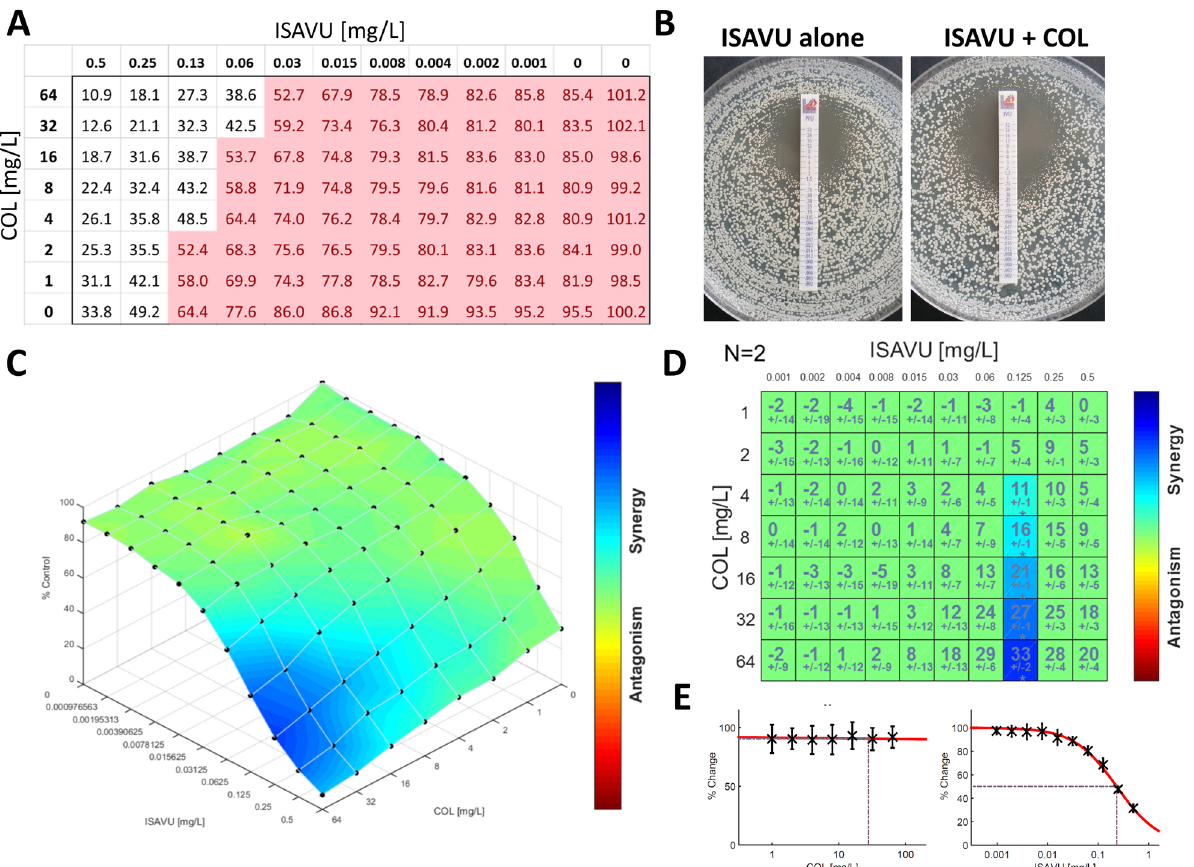
Figure 1. Comparison of the in vitro techniques and interpretation models for the synergistic interaction between isavuconazole (ISAVU) and colistin (COL) against C. auris isolate CBS 12771. ( A ) Percentage of growth compared to the growth control on the 96 wells microplate; ( B ) Agar diffusion assay: left side, isavuconazole alone; right side isavuconazole + colistin at 64 µg/mL incorporated in the agar; ( C ) Response surface analysis, based on the Bliss model, showing the mapping of the synergy levels on the experimental combination dose– response surface; ( D ) Synergy distribution, in matrix format, derived from the combination dose–response and the reference dose–response; ( E ) Response curves of the drugs alone. Panels C, D, and E were generated with the software Combenefit, version 2.021 38